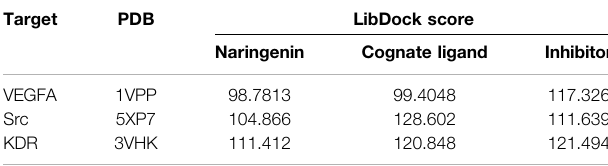
TABLE 1 | LibDock analysis of core targets bound with different molecules.